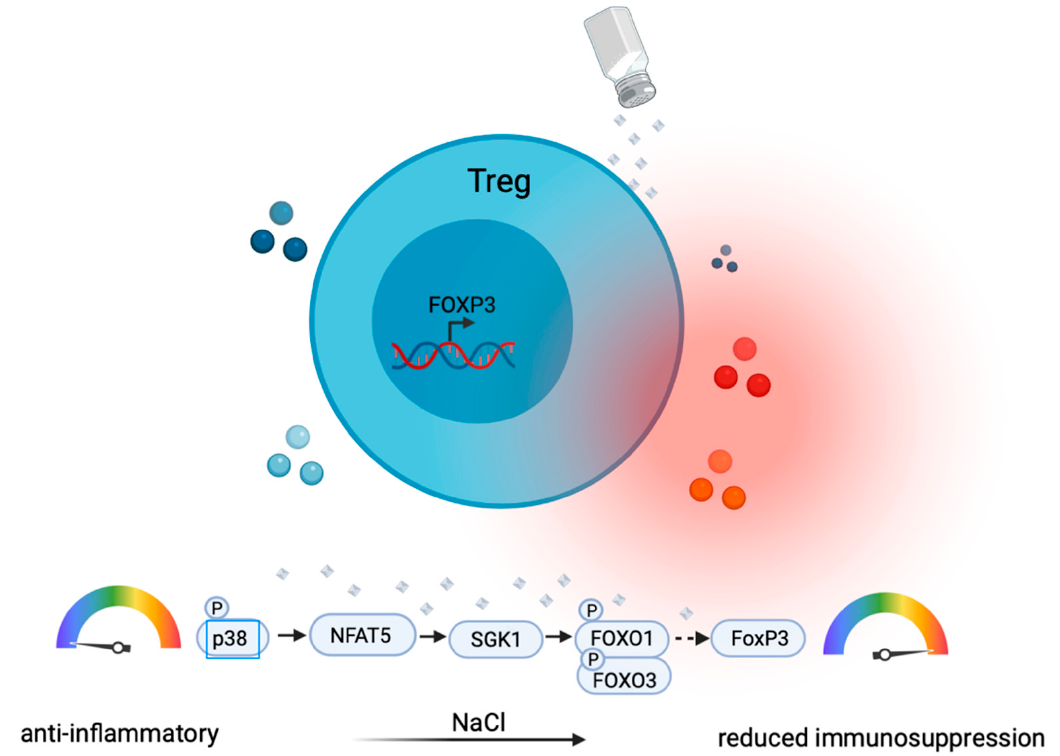
Figure 3. Sodium chloride compromises the anti-inflammatory function of Treg cells by the upregulation of proinflammatory (IFN- γ , IL-17) and downregulation of anti-inflammatory cytokines (IL-10). Sodium chloride leads to phosphorylation of p38 mitogen-activated protein kinase (MAPK), then activation of NFAT5 followed by the upregulation of SGK-1. Forkhead box O1 (FOXO1) and Forkhead box O3 (FOXO3) stabilize the FOXP3 locus, a process, which is compromised by their SGK-1-induced phosphorylation. This promotes the loss of anti-inflammatory Treg functions paired with proinflammatory cytokine production (IL-17, IFN- γ ).